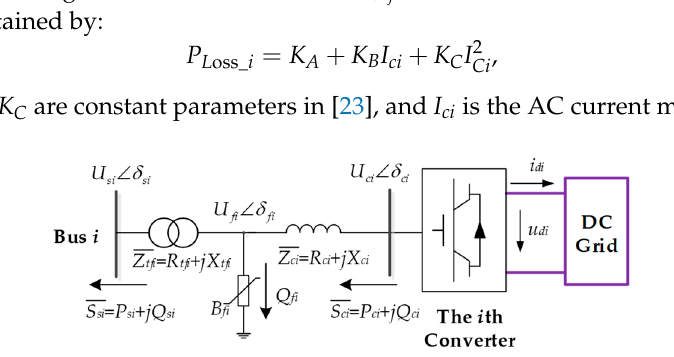
Figure 1. A steady-state model of a Voltage Source Converter station.